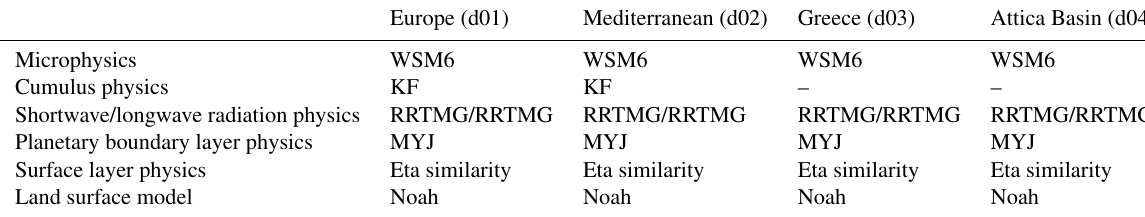
Table 2. The WRF physics schemes used.